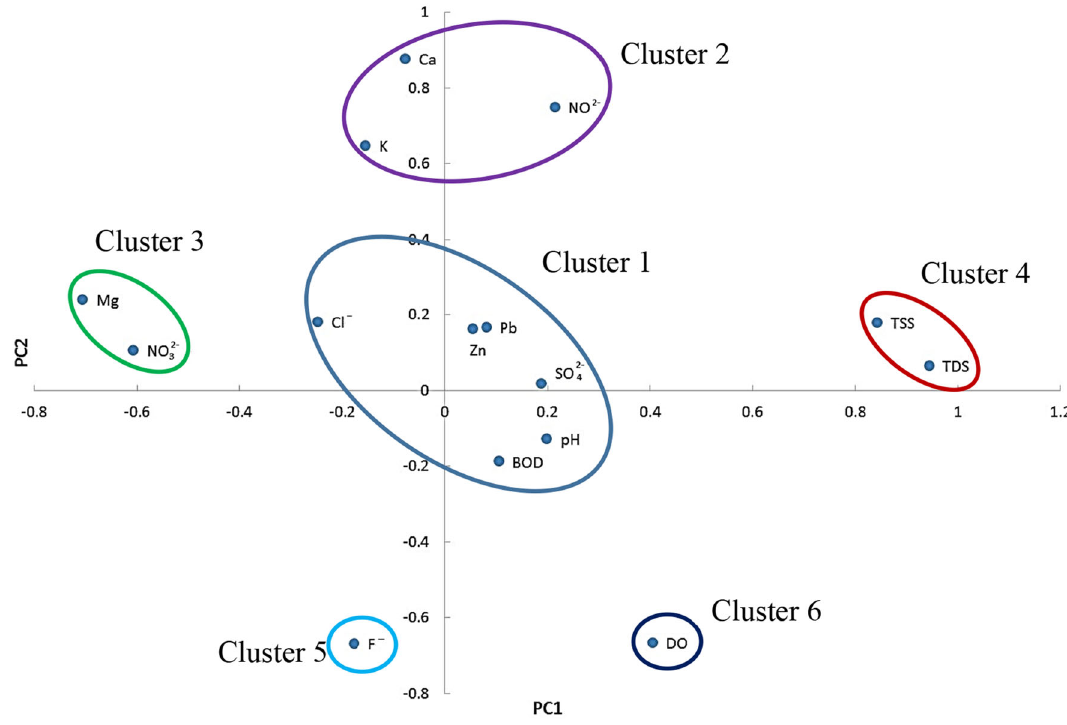
Fig. 2 Plots of PC1 vs. PC2 showing all analyzed parameters